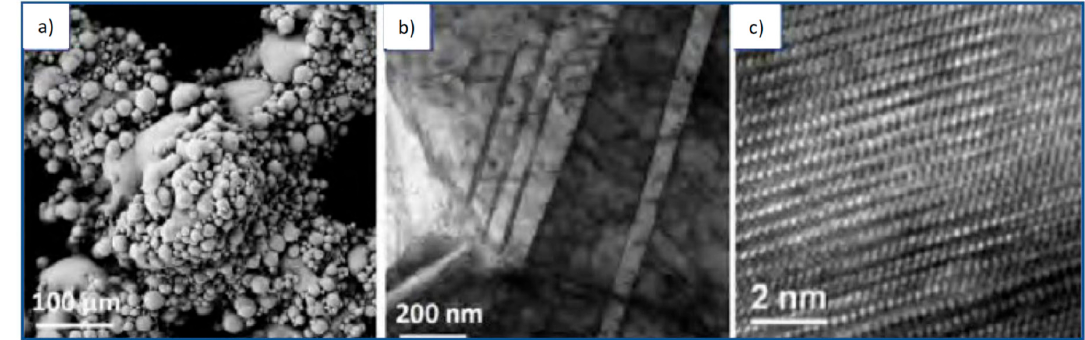
Figure 29. The procedure for manufacturing dental bridges using solid metal block milling technology; ( a ) a dental impression which is then scanned directly from the impression spoon; ( b ) the verification of the parallelism of the pillars; ( c ) the finished foundation design for transferring from CAD to CAM; ( d ) using the CNC milling center, the foundation is produced; ( e ) the finished element after cutting; ( f ) the prosthetic restoration veneered with porcelain; ( g ) the bridge installed in the patient mouth. Figure 30. Structure of selectively laser-sintered titanium; ( a ) skeleton topography with a pore diameter of ~450 µm (SEM); ( b ) Ti- α martensite crystal structure in the thin foil (TEM); ( c ) distribution of Ti atoms in Ti- α martensite (HRTEM).